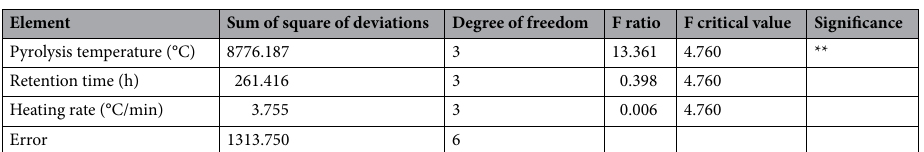
Table 4. Variance analysis. P < 0.01 indicates a very significant difference represented by